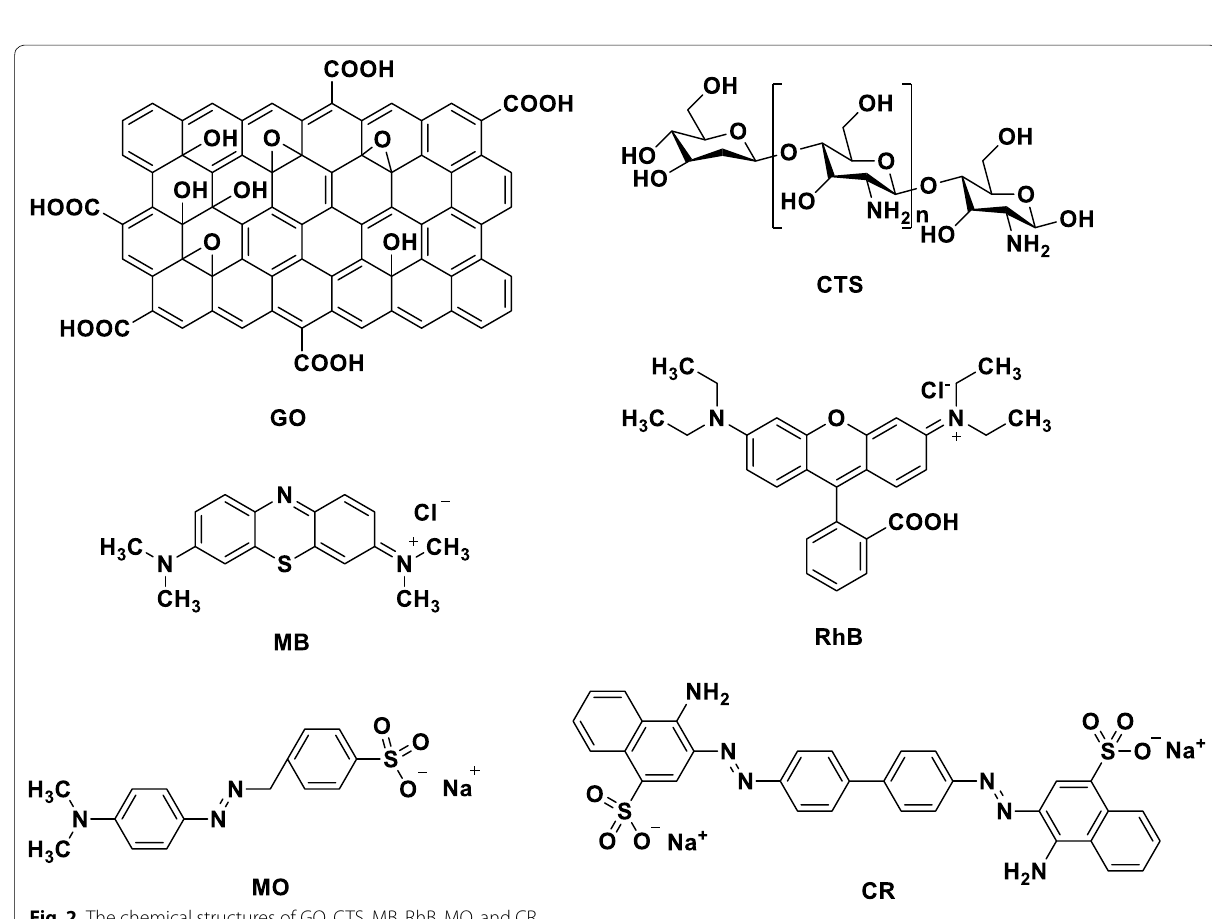
Fig. 2 The chemical structures of GO, CTS, MB, RhB, MO, and